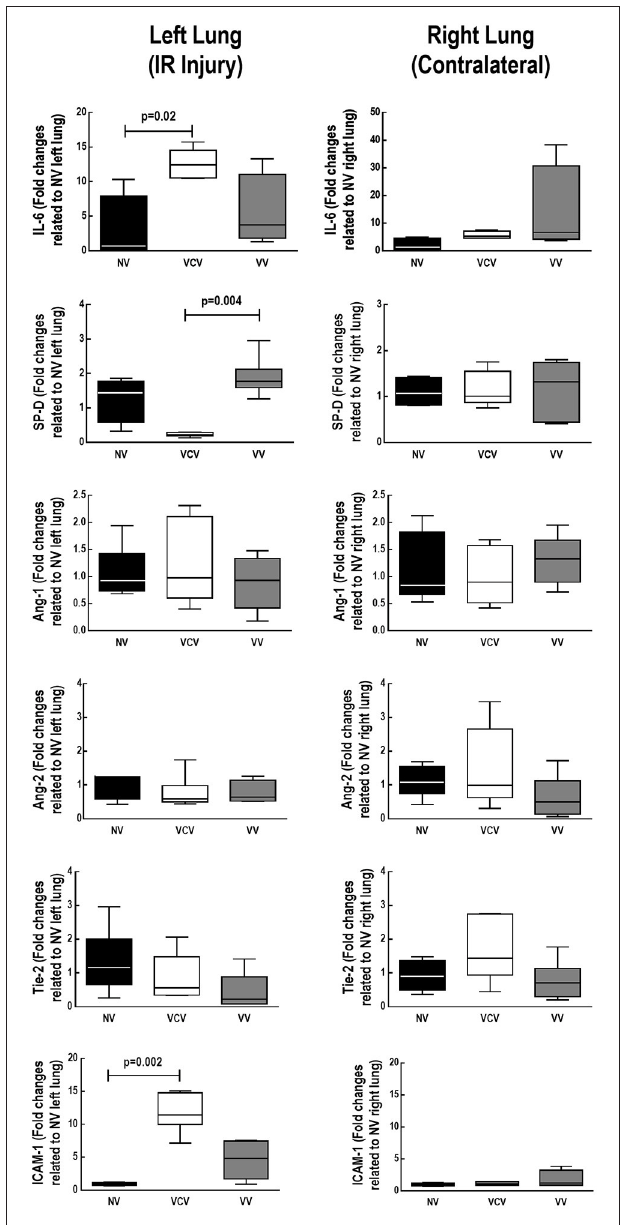
FIGURE 4 | Real-time polymerase chain reaction analysis of biological markers associated with inflammation [interleukin (IL)-6]; type II epithelial cell damage [surfactant protein (SP)-D]; and endothelial cell damage [angiopoietin (Ang) 1 and 2, receptor tyrosine kinase of Tie family (Tie), and intercellular adhesion molecular (ICAM)-1]. VCV: volume controlled ventilation; VV: variable controlled ventilation. Left lung: ischemia-reperfusion injury; right lung: contralateral. Values represent medians and whiskers represent the 10–90 percentile range of 6 animals in each group. Relative gene expression was calculated as a ratio of the average gene expression levels compared with the reference gene ( 36B4 ) and expressed as fold change relative to non-ventilated (NV) left lung or NV right